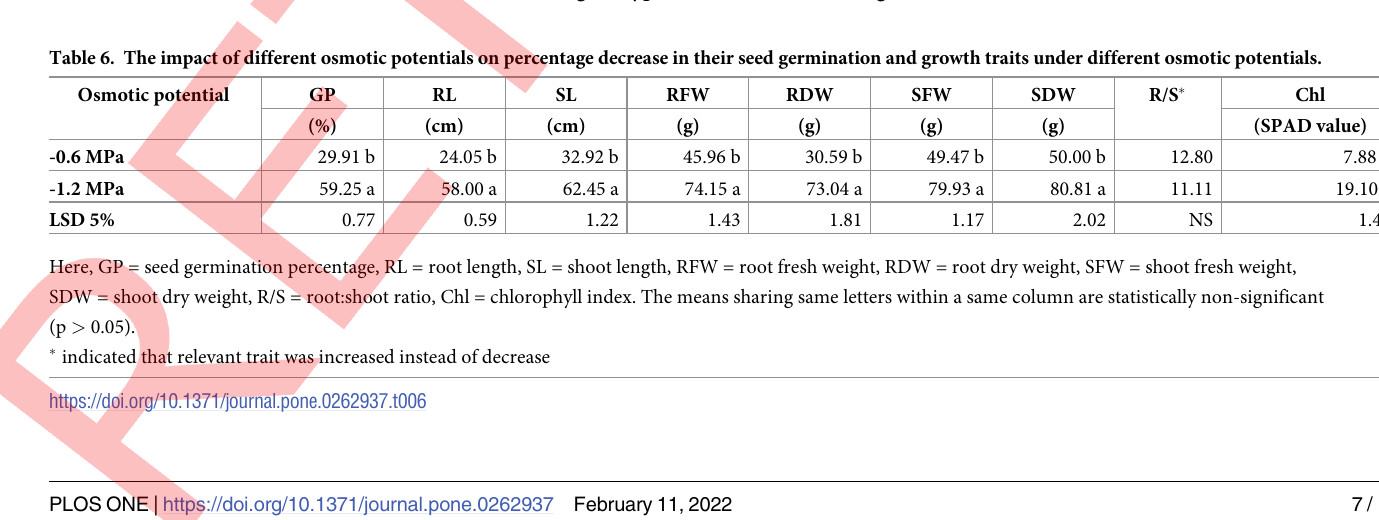
Regarding genotypes by drought stress interaction, the genotype ‘Seher’ with -1.2 MPa treatment recorded the highest decrease in seed germination percentage, root and shoot length, fresh and dry weights of roots and shoot, and chlorophyll index, whereas the lowest decrease in these traits were noted for the genotypes ‘J4’ under -0.6 MPa osmotic potential (Table 7). The genotypes ‘J4’ and ‘KTDH-16’ better tolerated increasing level of drought stress compared to the rest of the treatments included in the study, whereas genotypes ‘Seher’, ‘716’ and ‘A12’ proved as the most sensitive genotypes. Principal component analysis executed on germination and growth traits of different geno- types yielded in two principal components (PCs) with eigenvalues > 1 (Table 8). The first two PCs collectively explained 91.86% variability in the dataset. The first PC was positively influ- enced by all measured traits except root:shoot ratio, whereas the second PC was positively affected by root:shoot ratio and chlorophyll index (Table 8). The biplot of first two PCs divided the genotypes in two major groups. The first group had three genotypes having similar seed germination percentage and growth-related traits, whereas the second group was not influenced by any studied traits. The first group contained the geno- types with higher drought tolerance while the second group included the genotypes with the lowest drought tolerance recorded in the current study (Fig 1). Principal component analysis executed on reductions in seed germination and growth traits of different genotypes in three PCs with eigenvalues > 1 (Table 9). The first three PCs Table 6. The impact of different osmotic potentials on percentage decrease in their seed germination and growth traits under different osmotic potentials. Osmotic potential GP RL SL RFW RDW